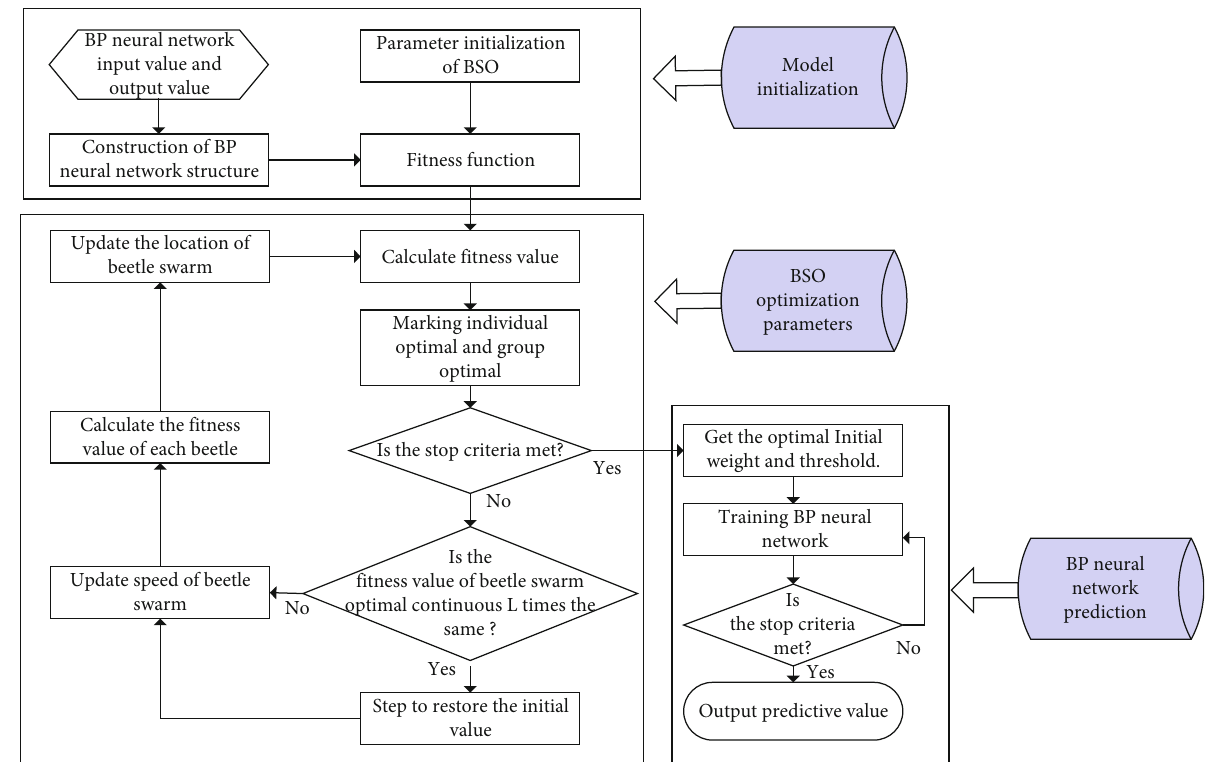
Figure 2: The work fl ow of the proposed BSO-BP algorithm.